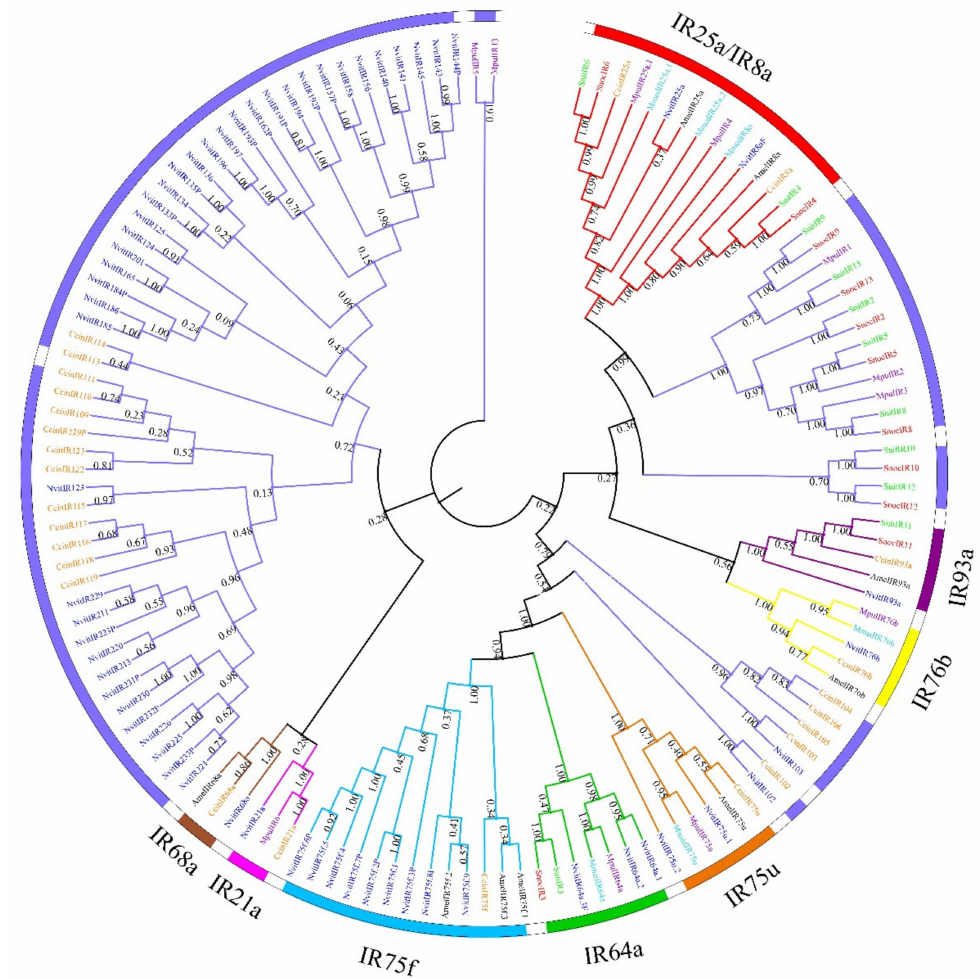
Figure 3. Phylogenetic tree of ionotropic receptor (IRs). The S. noctilio genes are displayed in red and S. nitobei genes are displayed in green. Mpul: M. pulchricornis ; Mmed: M. mediator ; Ccin: C. cinctus ; Nvit: N. vitripennis ; Amel: A. mellifera . The Amino acid sequences used for the phylogenetic tree are listed in Additional File S4. Four pairs of orthologous IRs exhibited more than 90% amino acid similarity, but compared to ORs, the homology between IRs in the same species was extremely low (0%–44%). Only one pair of IRs displayed an amino acid similarity greater than 40% between the two closely related woodwasp species (Supplementary File S2, Tables S3, S4 and